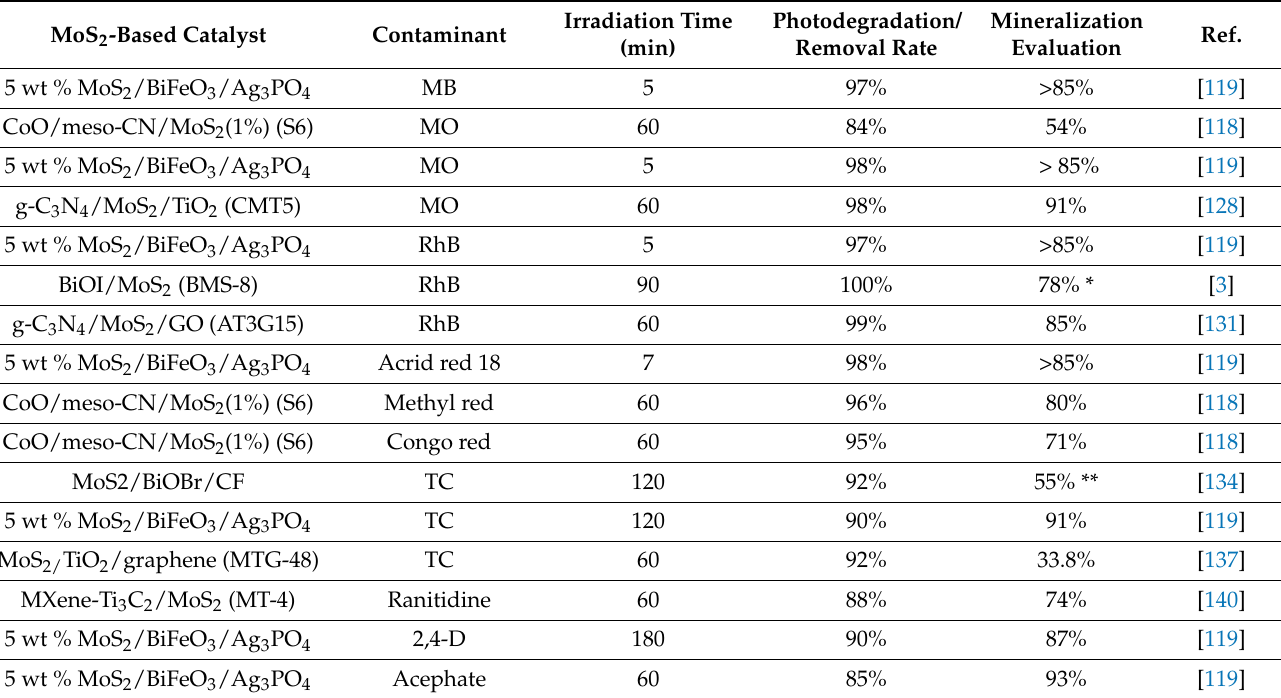
Table 3. Photodegradation rate and mineralization evaluation on photocatalytic studies, with MoS 2 - based